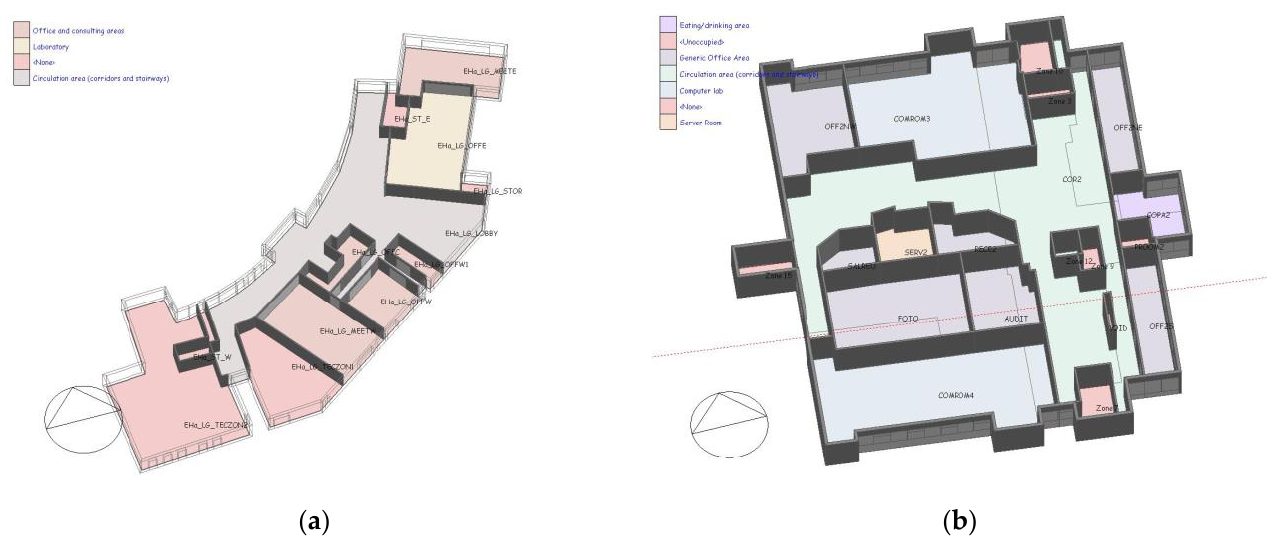
Figure 2. Example of thermal zones: ( a ) GB; ( b ) non-GB.